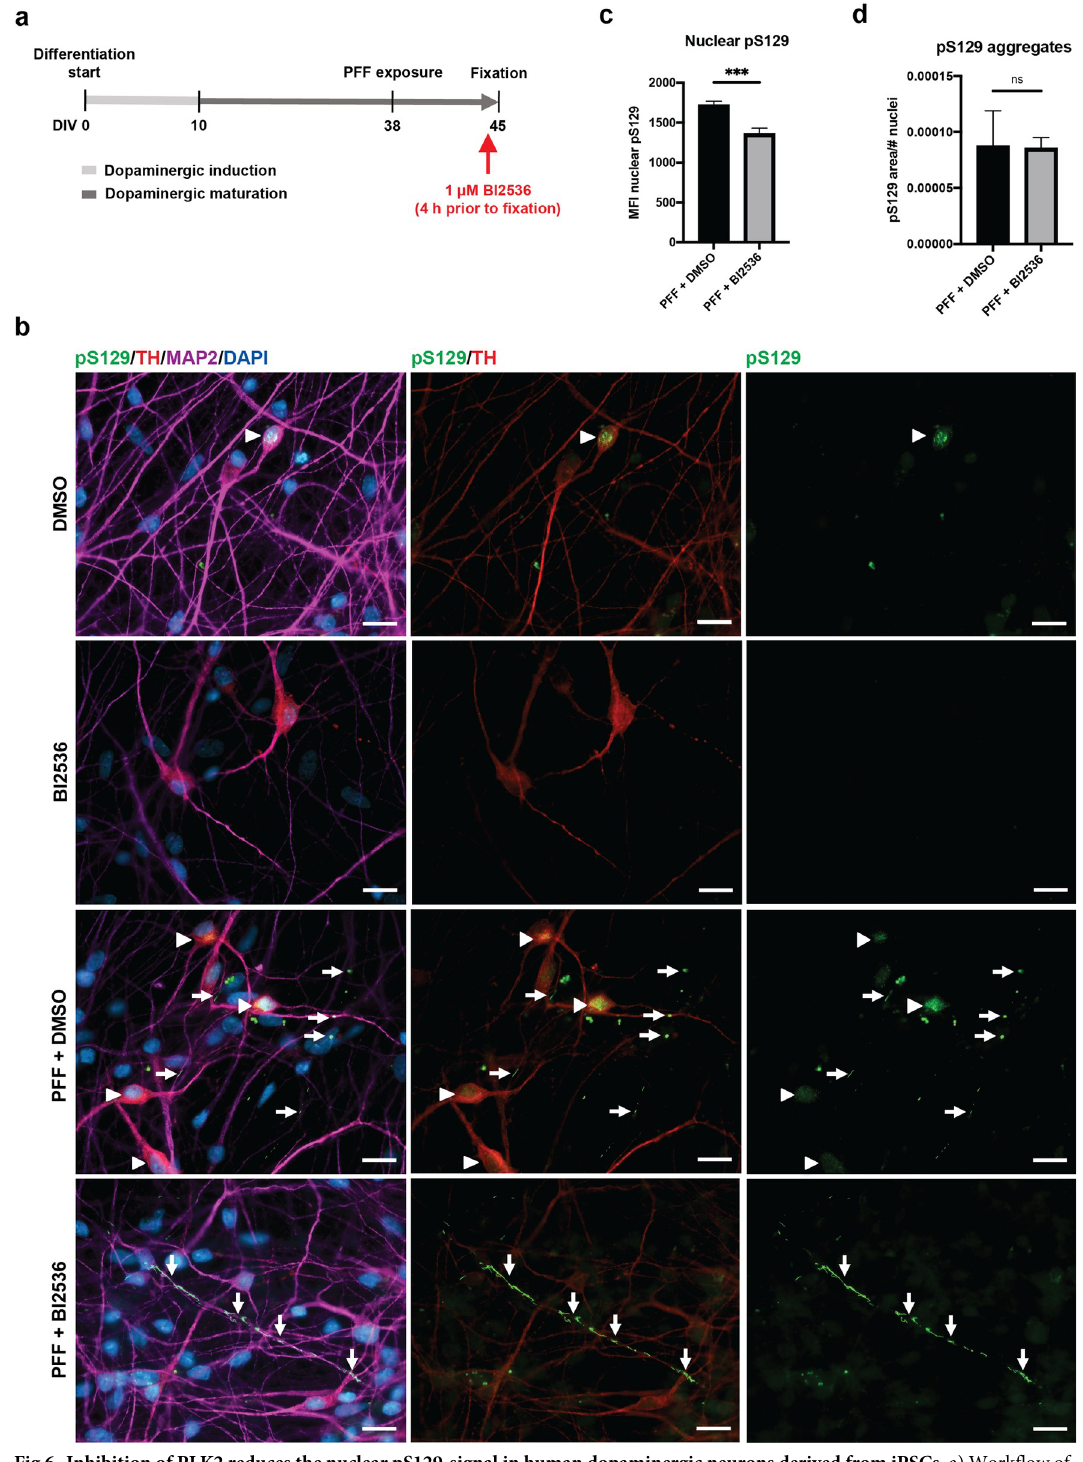
Fig 6. Inhibition of PLK2 reduces the nuclear pS129-signal in human dopaminergic neurons derived from iPSCs. a) Workflow of the experiment where the PLK1-3 inhibitor (BI2536) was added 4 h before fixing the cells for ICC. b) Representative images of iPSC- derived mature neurons visualized using MAP2 as a pan-neuronal marker, TH as dopaminergic neuronal marker, pS129 (11A5) and DAPI as a nuclear counterstain. For DMSO-treated cells, the staining shows bright nuclear pS129-signals (arrowheads), which disappear when cells are treated with BI2536, leaving the aggregate-specific pS129-staining easily detectable (arrows). Scale